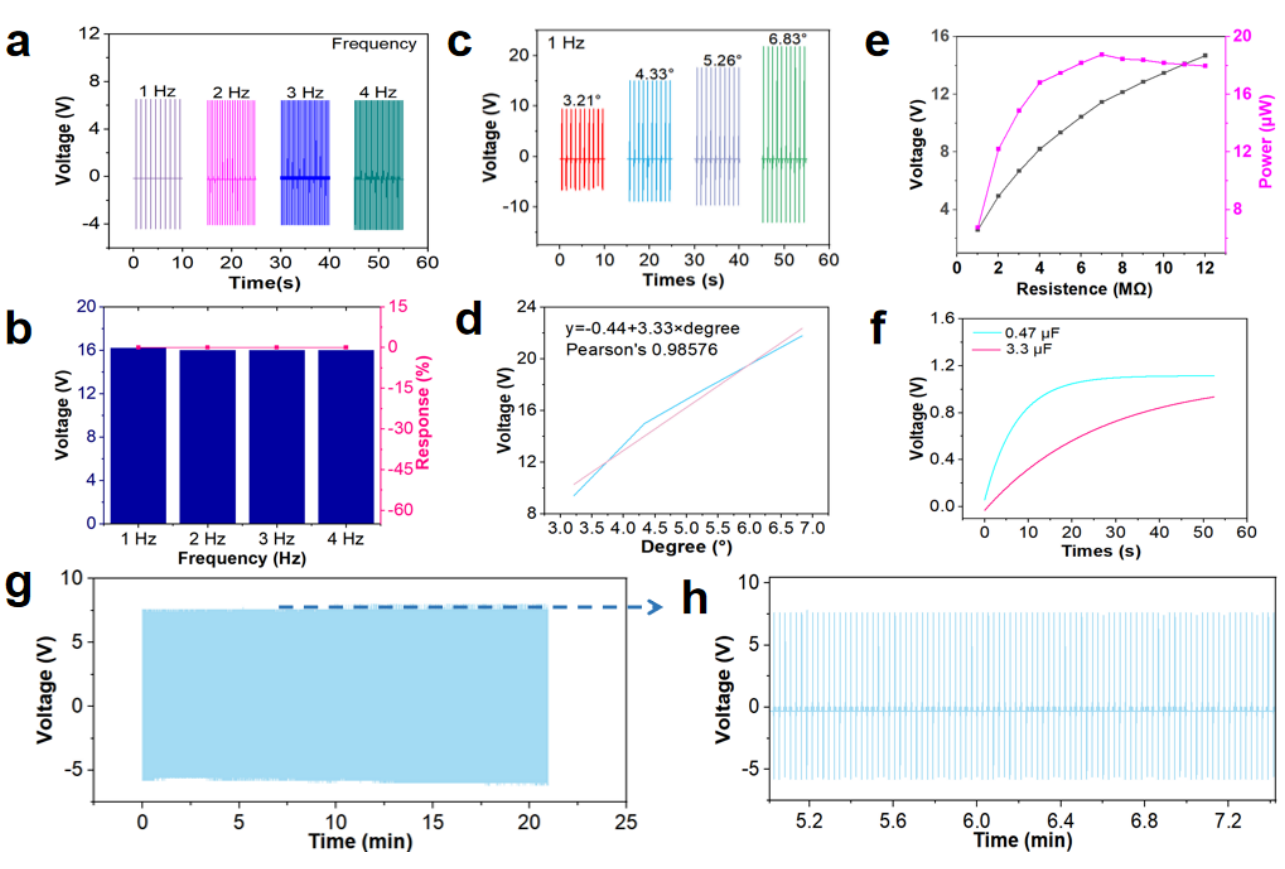
Figure 2. Performance test of LS ‐ TENG. ( a ) Output voltage of LS ‐ TENG at the same angle and different frequencies. ( b ) Output voltage response at the same angle and different frequencies. ( c ) Output voltage of LS ‐ TENG at the same frequency and different angles. ( d ) There is a linear relationship between the output voltage and the bending angle at the same frequency and different bending angles. ( e ) Voltage and power of LS ‐ TENG at different load resistances. ( f ) LS ‐ TENG charges 0.47 μ F and 3.3 μ F capacitors. ( g ) Durability test of LS ‐ TENG. ( h ) Details of LS ‐ TENG durability test.